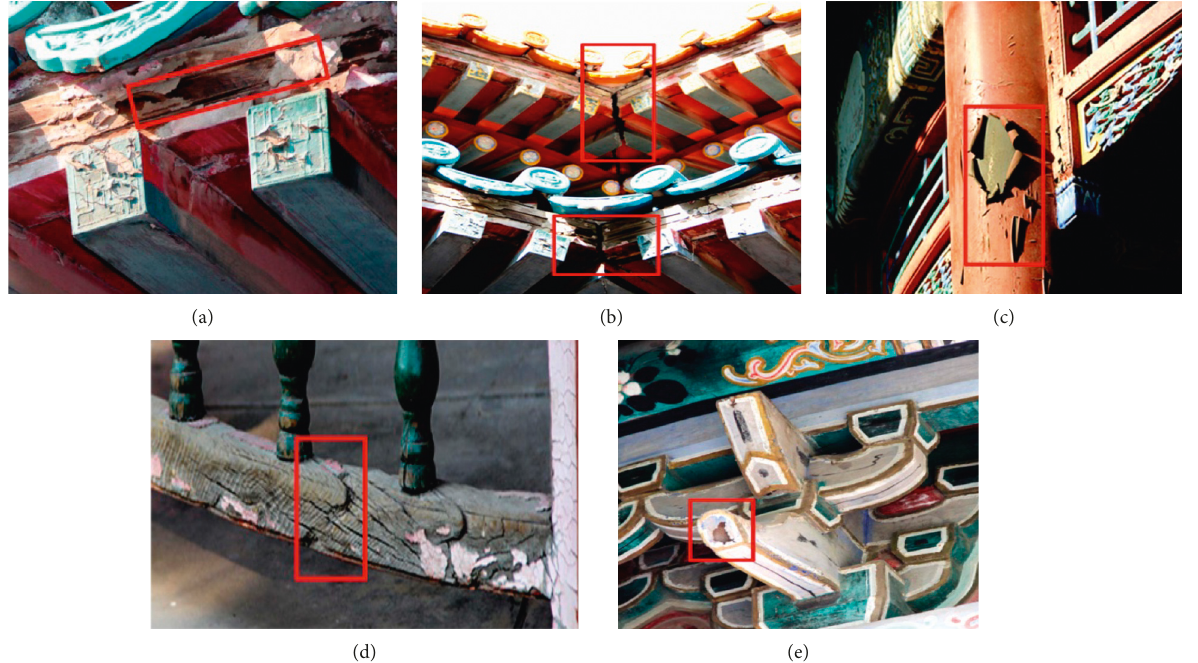
Figure 1: Surface damages of the pavilion: (a, b) eaves; (c) a pillar; (d) a fence; (e) the Ang.